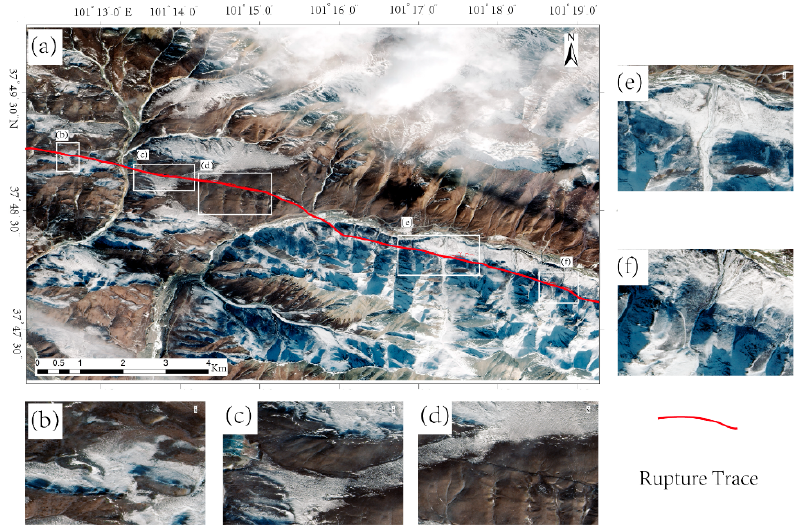
Figure 5. Surface rupture of the 2022 Menyuan earthquake identified in Gaofen-7 satellite optical images. ( a ) The red curve indicates the identified fracture trace. ( b – f ) Enlarged details of the white rectangles in ( a ).